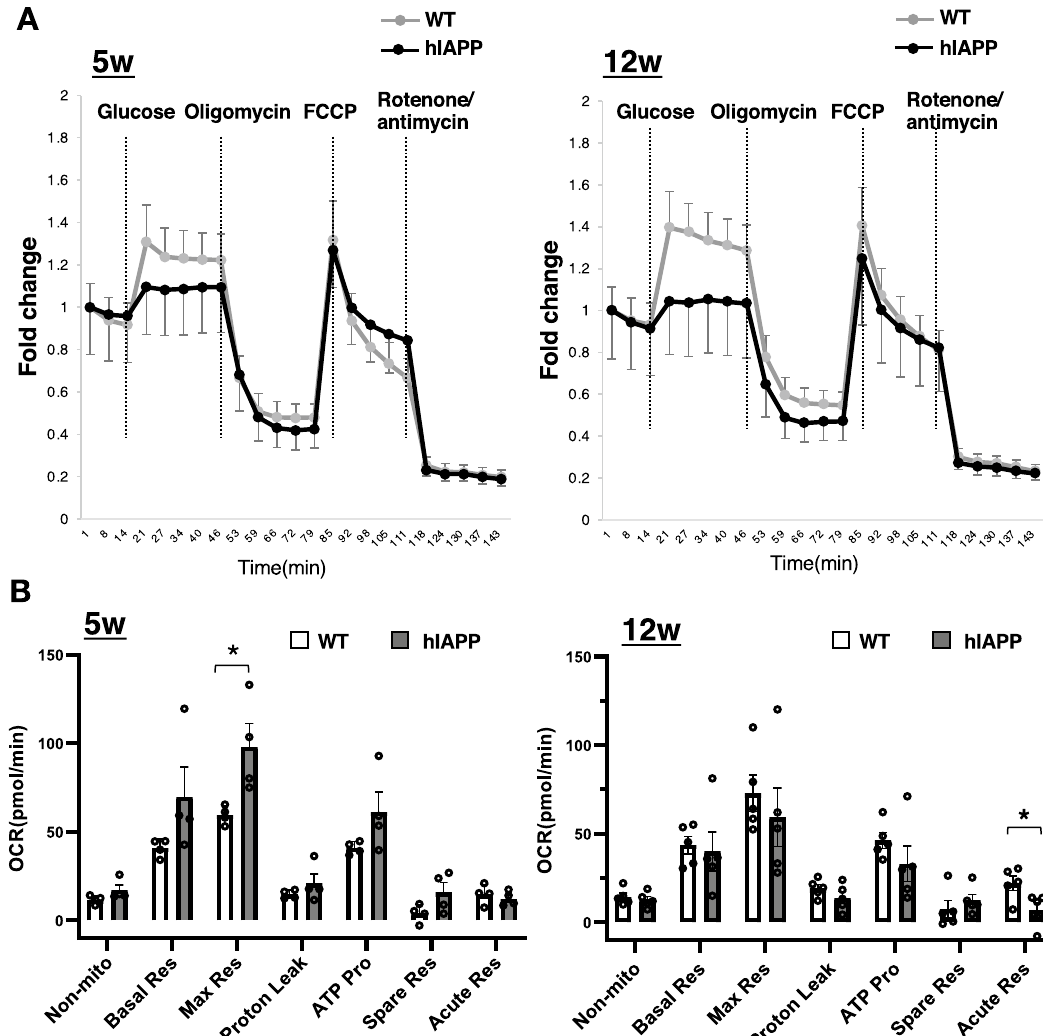
Figure 7. Mitochondrial function of 5- and 12-week-old hIAPP-Tg mice. ( A ) Fold-increase in the oxygen consumption rate of mice (n = 4 for 5-week-old mice, n = 5 for 12-week-old mice). ( B ) Analyzed data are shown as a graph. Non-mito: nonmitochondrial oxygen consumption; Basal Res: basal respiration, Max Res: maximal respiration, Proton Leak, ATP Pro: ATP production, Spare Res: spare respiratory capacity, Acute Res: acute response. Max Res and Acute Res are calculated by the equation as (maximum rate measurement after FCCP injection)—(non-mitochondrial respiration) and (late rate measurement before oligomycin injection)—(last rate measurement before acute injection), respectively. WT: WT mice, hIAPP: hIAPP-Tg mice, Data are shown as means ± SEM. * p < 0.05 (WT vs.